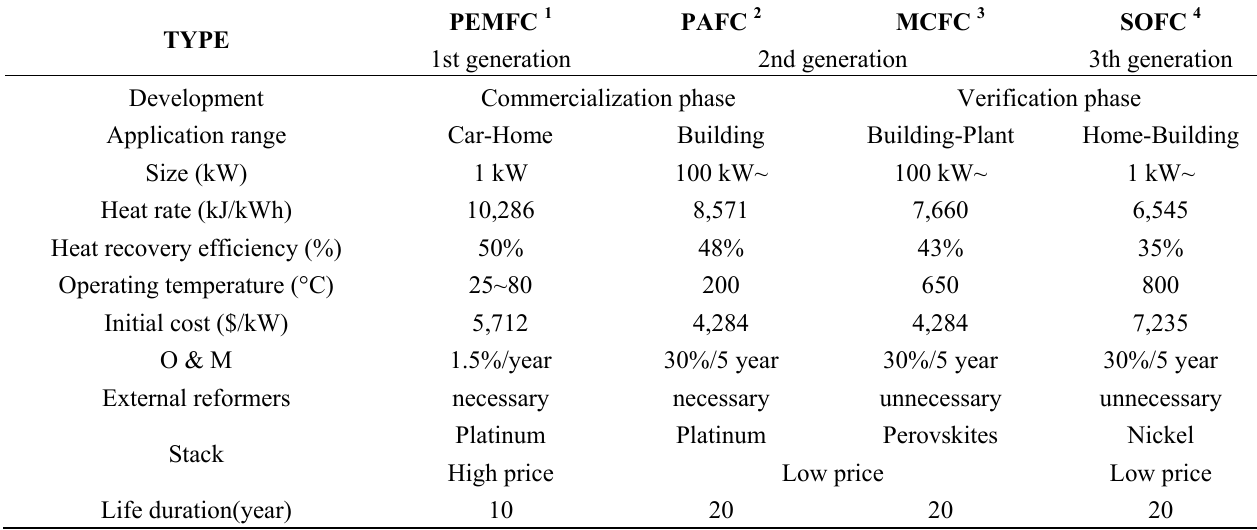
Table A3. Specifics of four types of a fuel cell